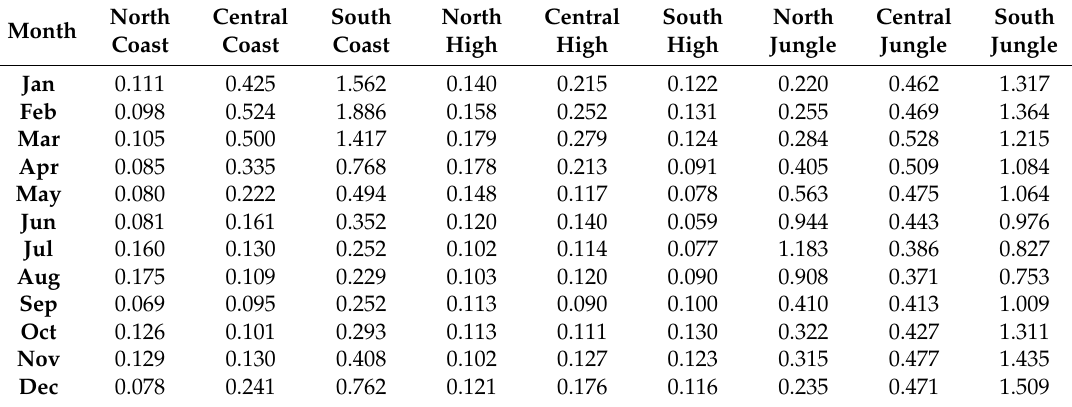
Table 3. Sill values (in cm 2 ) for the omnidirectional semivariogram analysis for each sub-region. Values obtained from the MODIS PWV product.